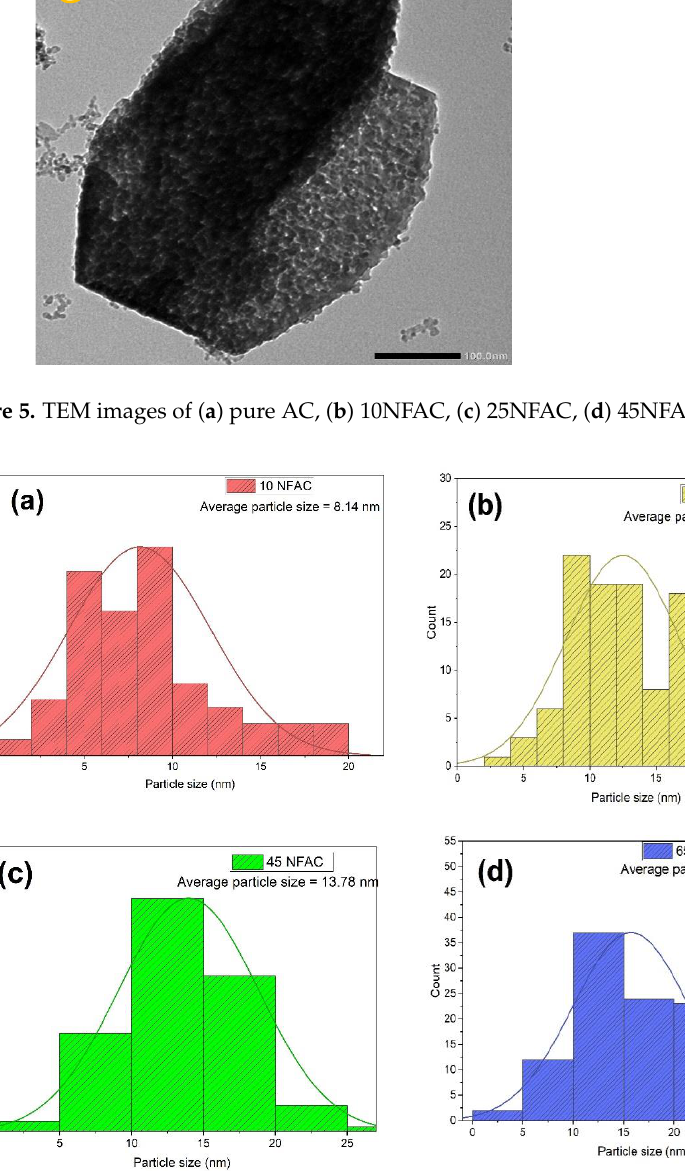
Figure 6. Particle size distribution histograms of ( a ) 10NFAC, ( b ) 25NFAC, ( c ) 45NFAC, and ( d ) 65 NFAC.